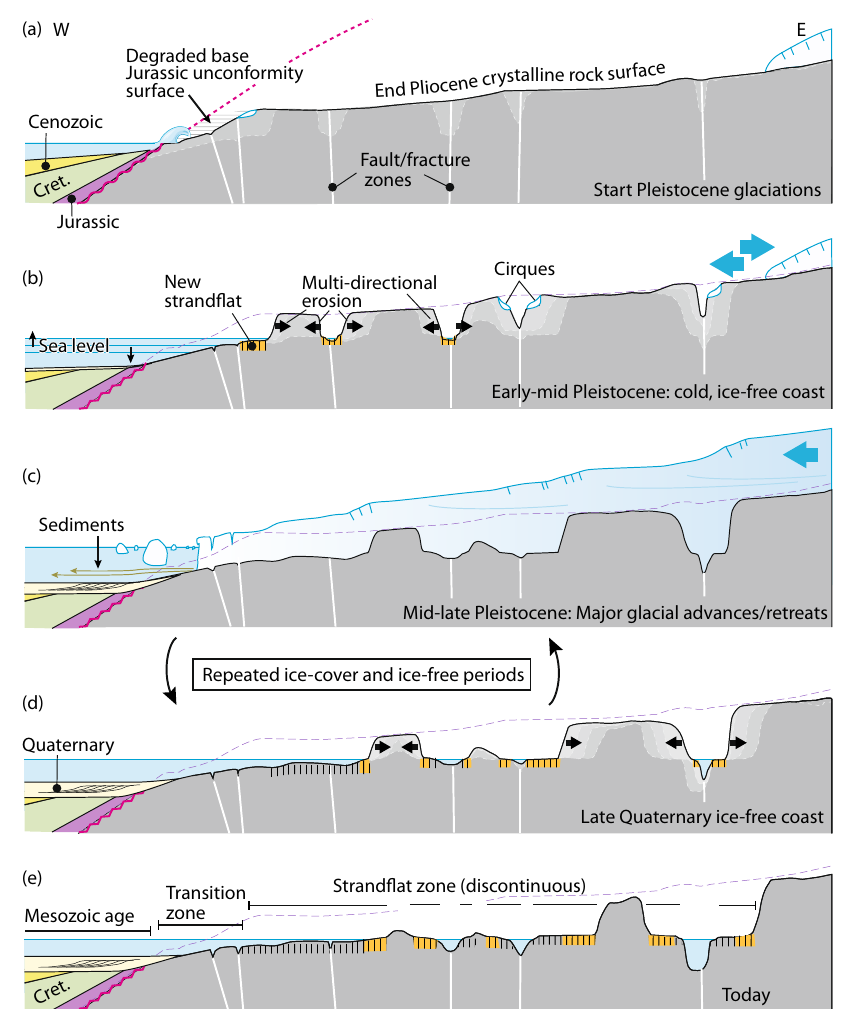
Fig. 10 Schematic evolutionary model for the strand fl at from the start of the Pleistocene until today. a The situation at the start of the Pleistocene, with a gently W-dipping elevated onshore topographic surface. This paleic surface is younger than the steeper base Jurassic unconformity to the west. b Strand fl at-forming cold-climate erosion during ice-free periods. The area is repeatedly covered by glaciers ( c ) that remove erosion products from the strand fl at, before returning to ice-free conditions ( d ). No further development of the strand fl at occurred in the Holocene, so e represents both the current and the end Pleistocene situation. Orange fi elds mark the most recent parts of the strand fl at at any given time. Throughout, erosion was guided by fault and fracture zones, simultaneously acting in different directions at different locations. Overall, however, the inner (eastern) part of the strand fl at is the youngest part. Note that the strand fl at is generally wider than shown